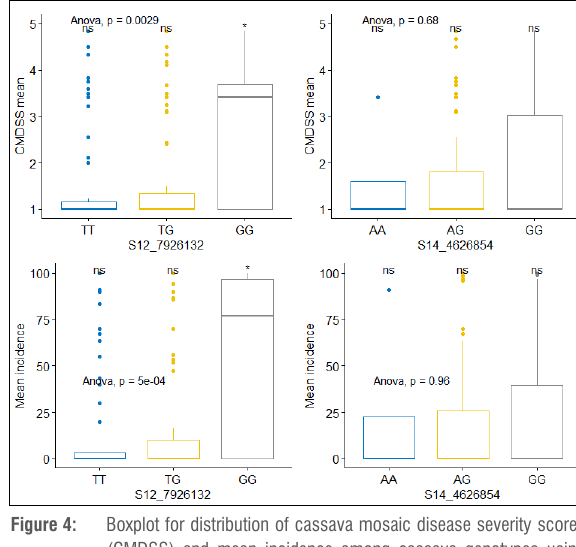
Figure 4: Boxplot for distribution of cassava mosaic disease severity scores (CMDSS) and mean incidence among cassava genotypes using the single nucleotide polymorphism markers S12_7926132 and S14_4626854: (left) marker S12_7926132 with TT=homozygote resistant, TG= heterozygote, GG=homozygote susceptible, and (right) marker S14_4626854 with AA=homozygote resistant, AG=heterozygote, GG=homozygote